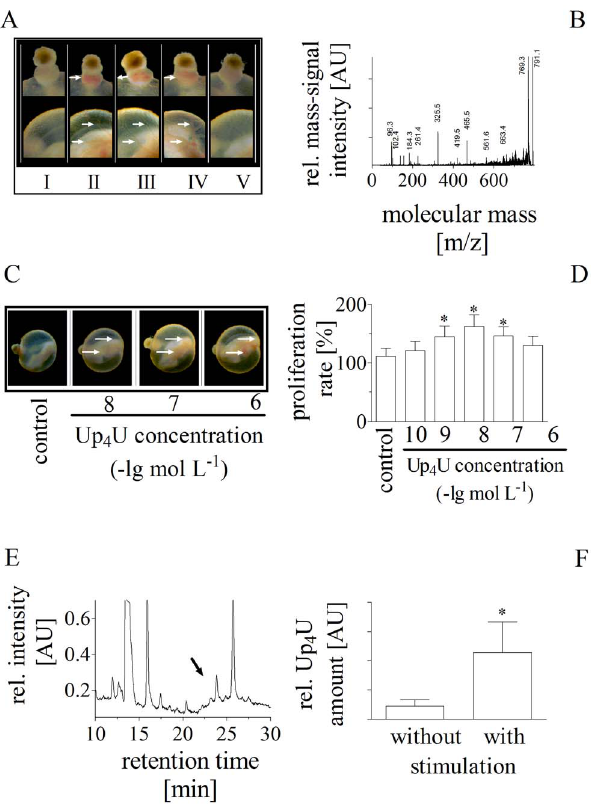
Figure 1. ( A ) Angiogenic effects of endothelial secretome in the rat embryo chorioallantoic membrane. The primitive placenta and yolk sac of rat embryos cultured during organogenesis under negative control conditions (HBSS and bovine serum) (I). The corresponding vascular system is underdeveloped and could be improved by angiogenic factors like VEGF as positive control (II). More complex and structured blood vessels and red staining caused by red blood cells in the blood vessels (marked by arrows). Morphologic evaluation of angiogenic effect of the endothelial secretome (III), of the endothelial secretome after incubation with alkaline phosphate (IV), and of the endothelial secretome after incubation with alkaline phosphate in the presence of suramin (V). ( B ) MALDI-TOF-TOF mass spectrum of the fraction from the analytical reversed-phase chromatography. ( C ) Enhanced vascularisa- tion of rat embryonic yolk sac membranes induced by increasing Up 4 U concentrations after 48 h of culture. Typical result out of 5 similar experiments. (D) Effect of increasing Up 4 U concentration on prolifer- ation rate of human endothelial cells (n=7). ( E ) Reversed phase chromatography of the fraction of human plasma containing the remaining nucleotides after exclusion of mononucleotides. ( F ) Up 4 U release of cultivated endothelial cells after stimulation by a cone-and- plate viscometer with shear stress of 3 N m -2 (n=11).